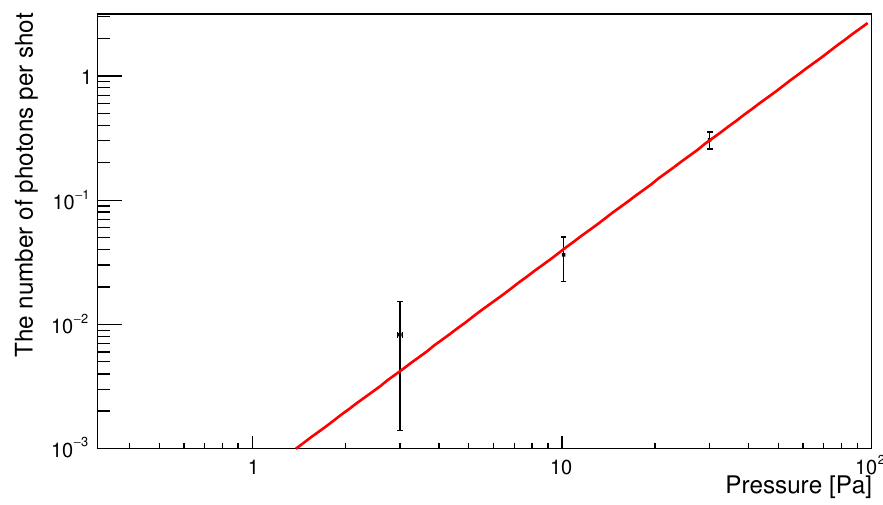
Figure 8 . Pressure dependence of number of four-wave-mixing photons per shot from residual atoms inside interaction chamber when P-pol. (creation) and left-handed circular (inducing) polar- ization laser pulses are combined and